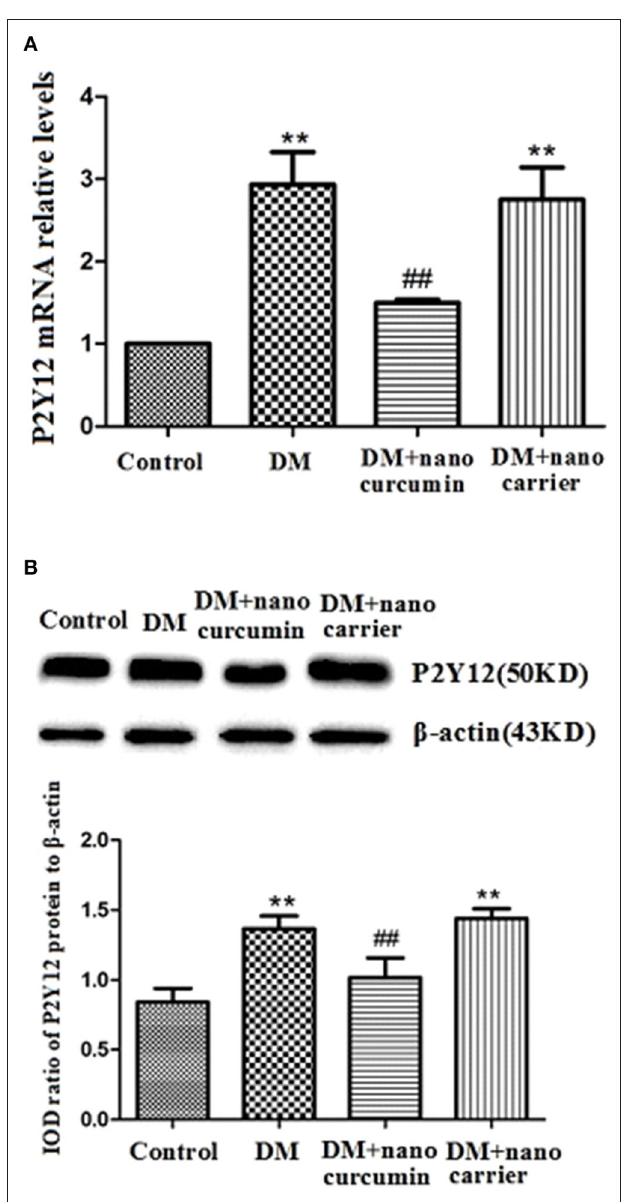
FIGURE 2 | Effects of nanoparticle-encapsulated curcumin on the expression of the P2Y12 mRNA and protein in the DRG of the DM rats. (A) The expression of the P2Y12 mRNA in the DRG was measured by RT-qPCR. Expression of the P2Y12 mRNA in the DM group was higher than that in the control group. In the DM + nanoparticle-encapsulated curcumin group, the P2Y12 mRNA expression were significantly decreased compared with those in the DM rats. The experiment was performed three times ( n = 7 per group). Data are presented as means ± SEMs. ** p < 0.01 compared to the control group; ## p < 0.01 compared to the DM group. (B) The expression of P2Y12 protein in the DRG was assessed by Western blotting. Protein expression was increased in the DM group compared to that in the control group. In the DM + nanoparticle-encapsulated curcumin group, the expression of P2Y12 protein was significantly lower than in the DM group. Bar graphs show the ratio of the levels of the P2Y12 protein to the β -actin protein in each group. Data are displayed as means ± SEMs. ** p < 0.01 compared to the ctrl group; ## p < 0.01 compared to the DM